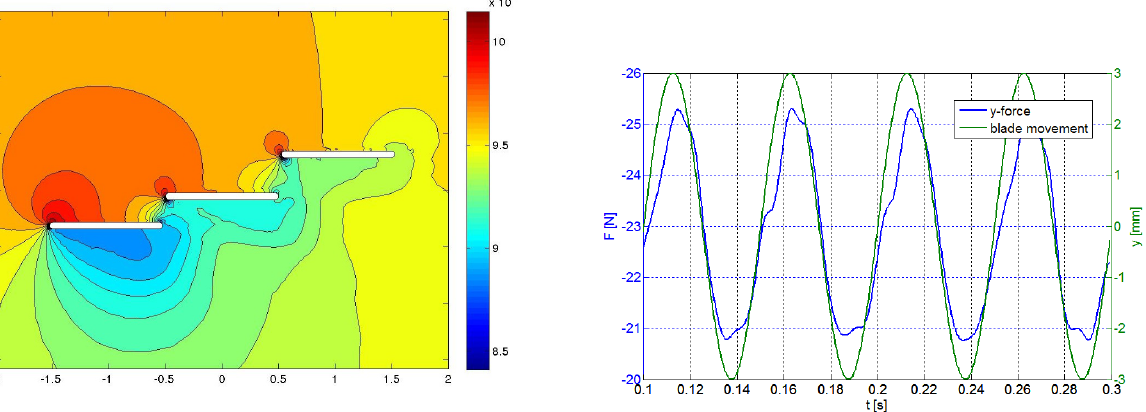
Fig. 9. Time development of vertical displacement (green) and y -component of aerodynamic force (blue) for the middle